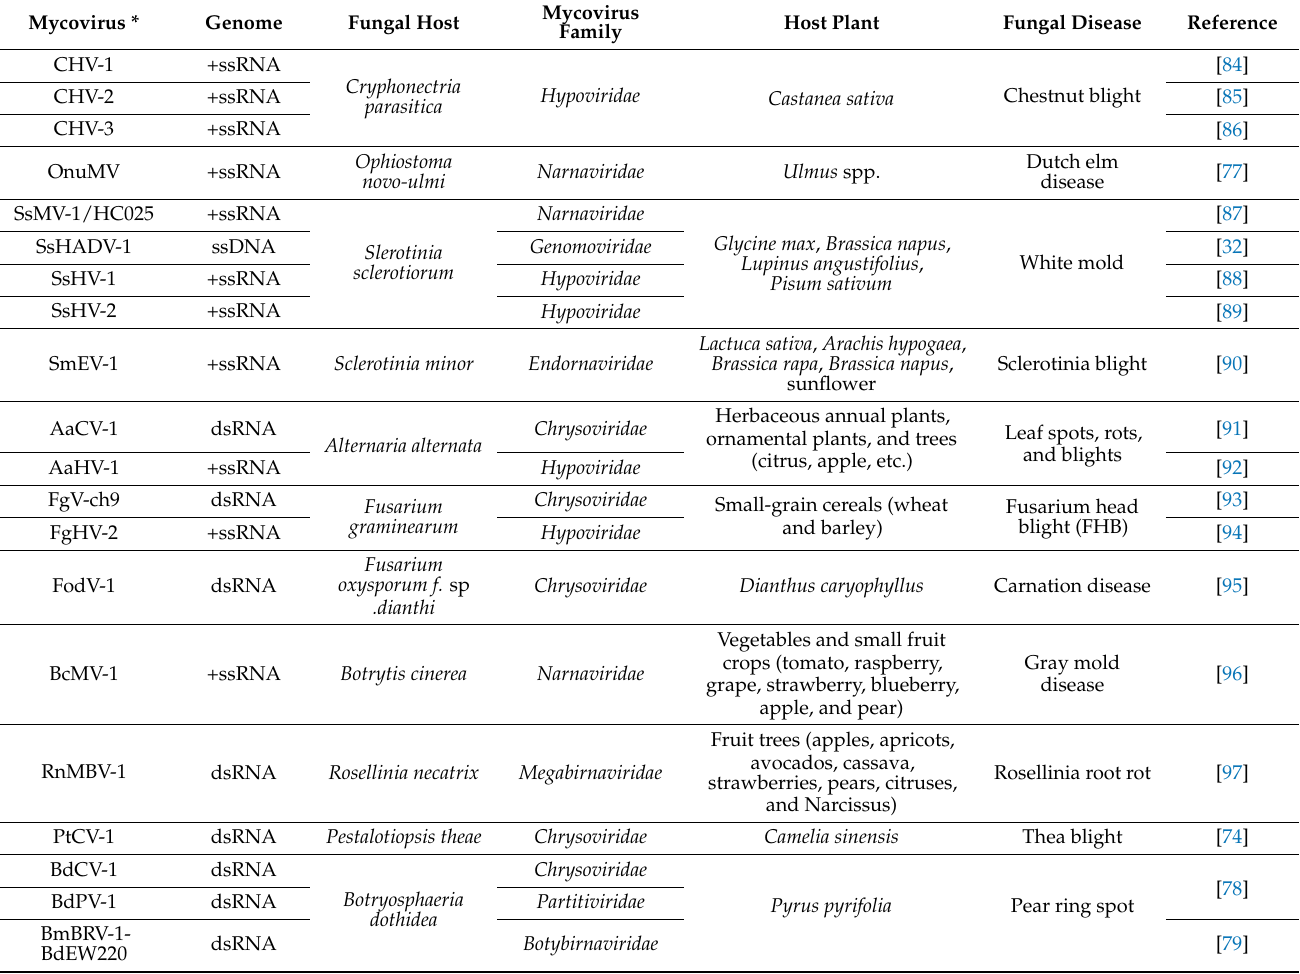
Table 2. Mycoviruses described in the literature that trigger hypovirulence in the fungal